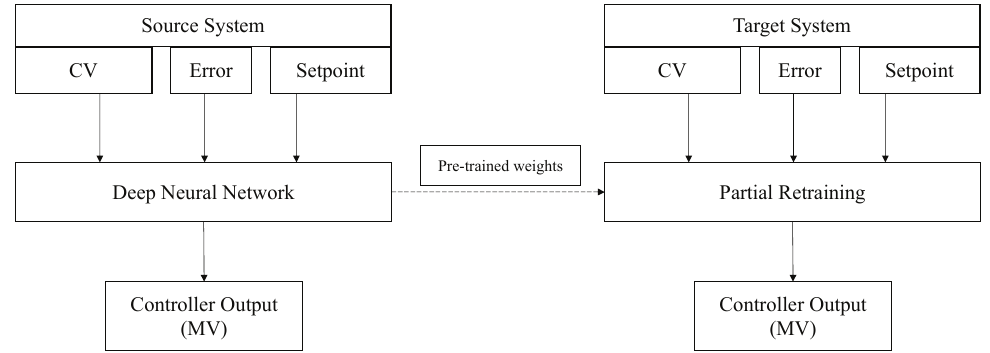
Figure 1. A network-based transfer-learning approach to develop an approximate MPC for a target system using data from a source